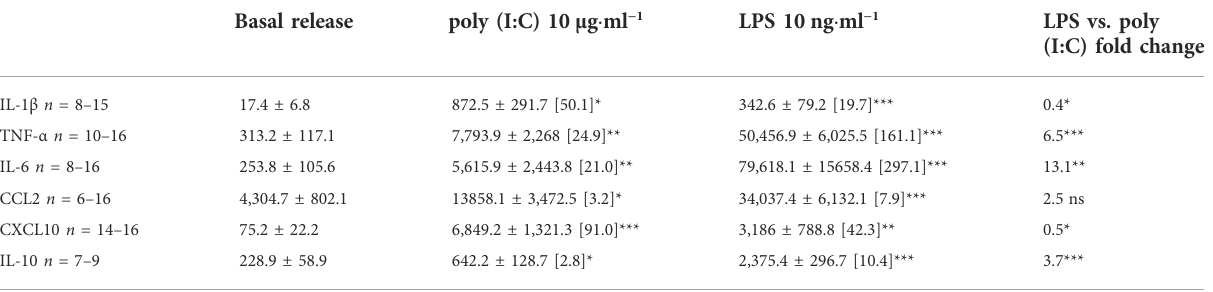
TABLE 2 Amounts of cytokines in the supernatants of human LMs treated for 24 h with LPS or poly (I:C).